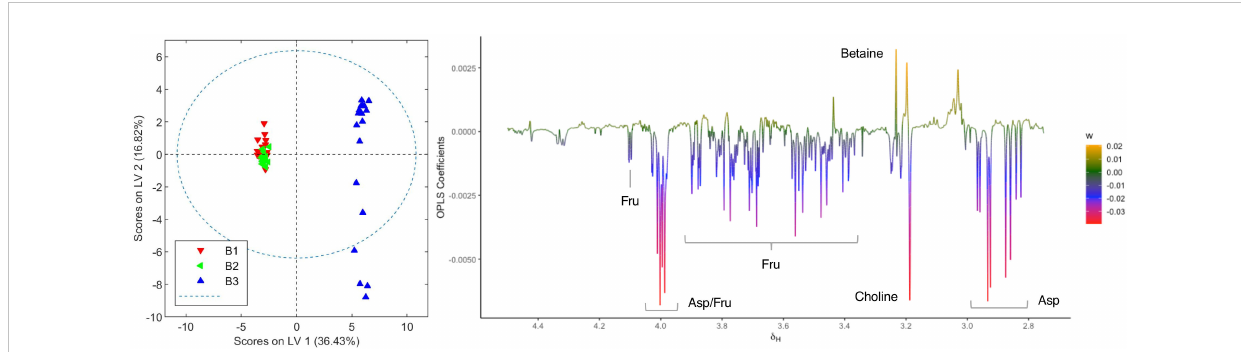
FIGURE 6 Score and loading factor plots obtained from the OPLS-DA between aqueous extracts of healthy and infected crops of chemovar B. The metabolites that differentiate the two groups are annotated in the loading factor plots. The R 2 Y and Q 2 Y coef fi cients for the model were 0.99 and 0.98, respectively, and the ROC curve had an AUC value of 1.00 (see Figures S15,